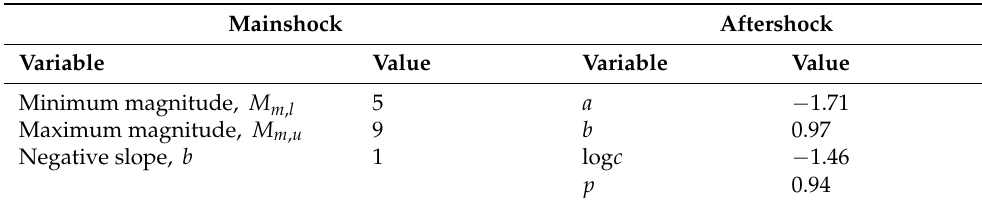
Table 4. Mainshock and aftershock